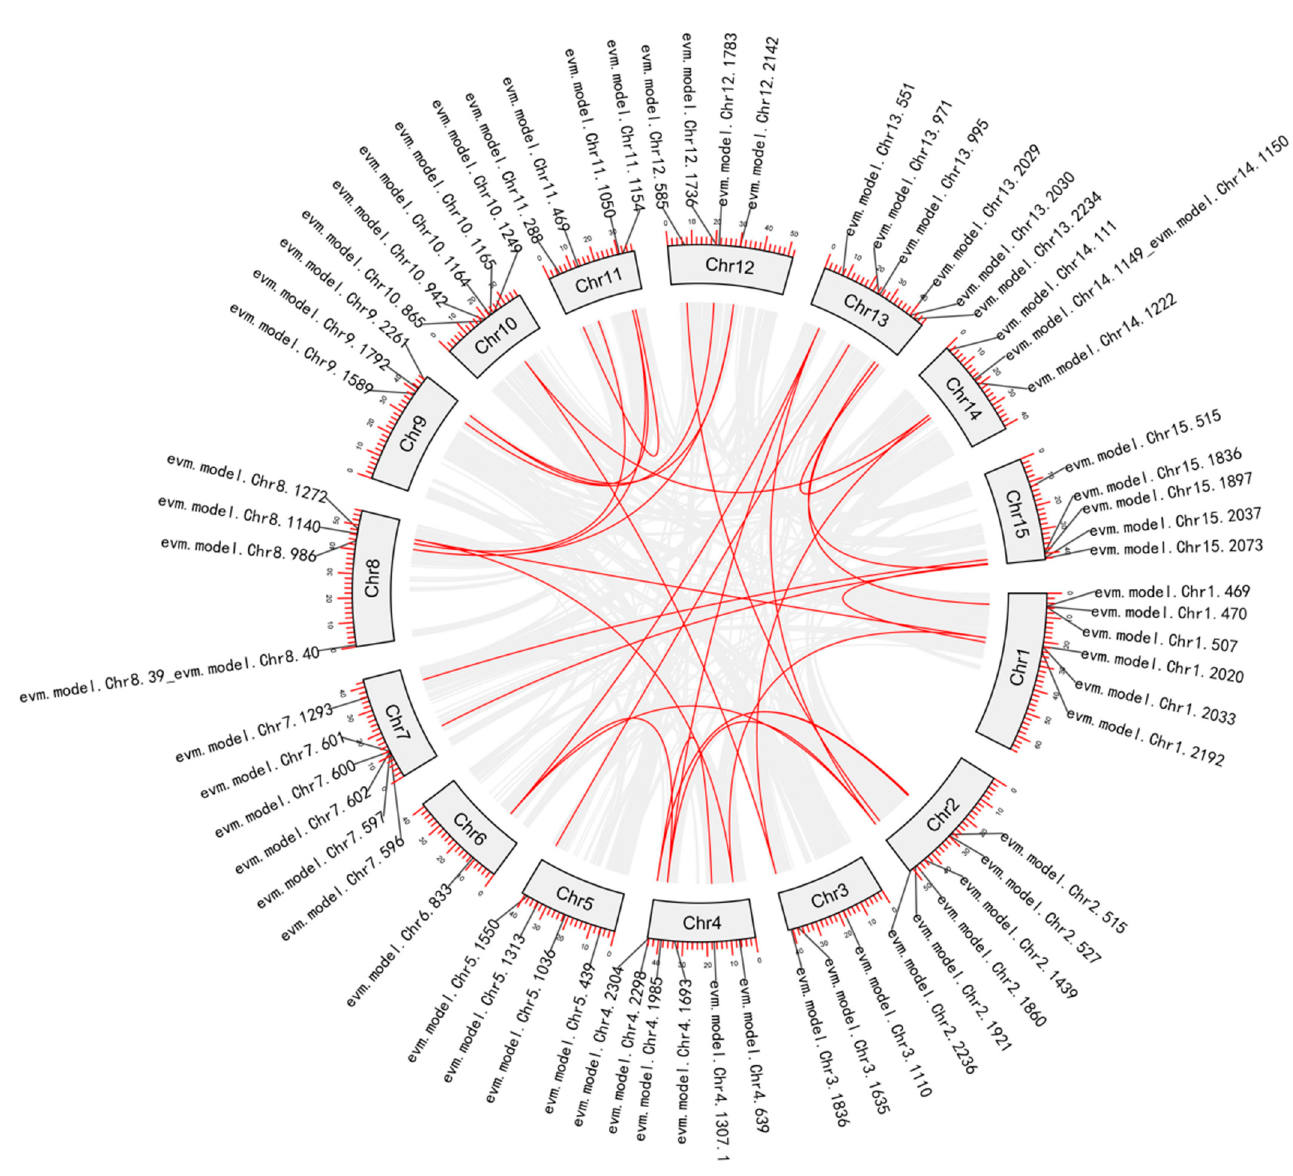
Figure 6. Distribution and duplication of DolWRKY s. Gray lines represent the chromosomes of D. oleifera . The scales on the chromosomes represent the chromosome length. The red lines indicate duplicated DolWRKY gene pairs.